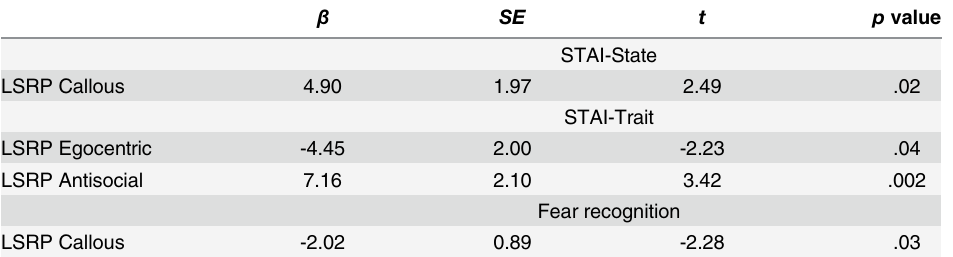
Table 3. Predictors of state anxiety, trait anxiety, social fear/anxiety, and social avoidance in an offending sample. β SE t p value STAI-State LSRP Callous 4.90 1.97 2.49 .02 -4.45